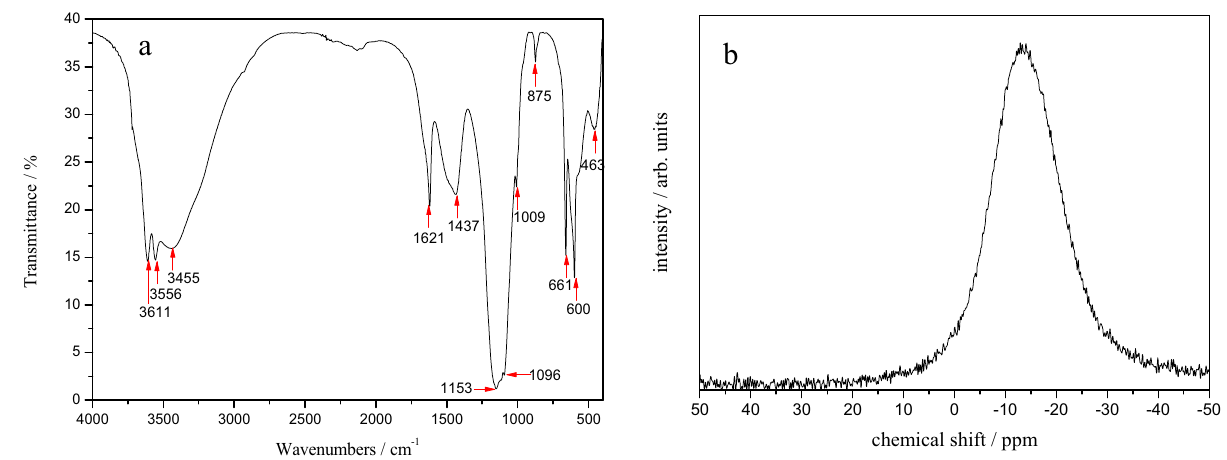
Figure 6: Infrared spectrum ( a ) and solid state 31 P NMR spectra ( b ) of the intermediate product ( HWWS - IP ) for iron and aluminum components separation under optimized conditions.